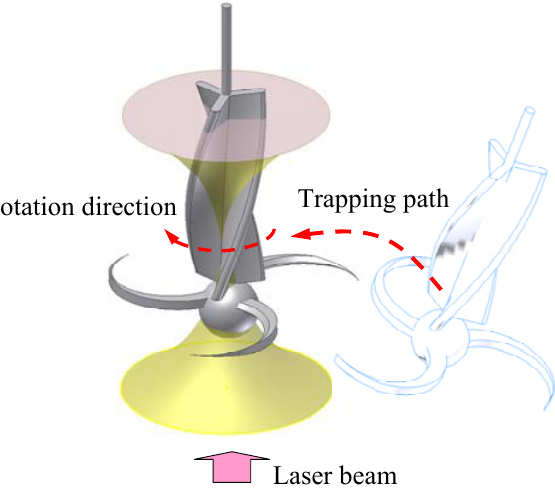
Figure 4. Schematic figures of the optically driven integrated micro-tool: once the optical tweezers turns on, the micro-tool is trapped toward the laser focus, and then the Archimedes screw is spontaneously rotated by the optical tweezers, and drives the